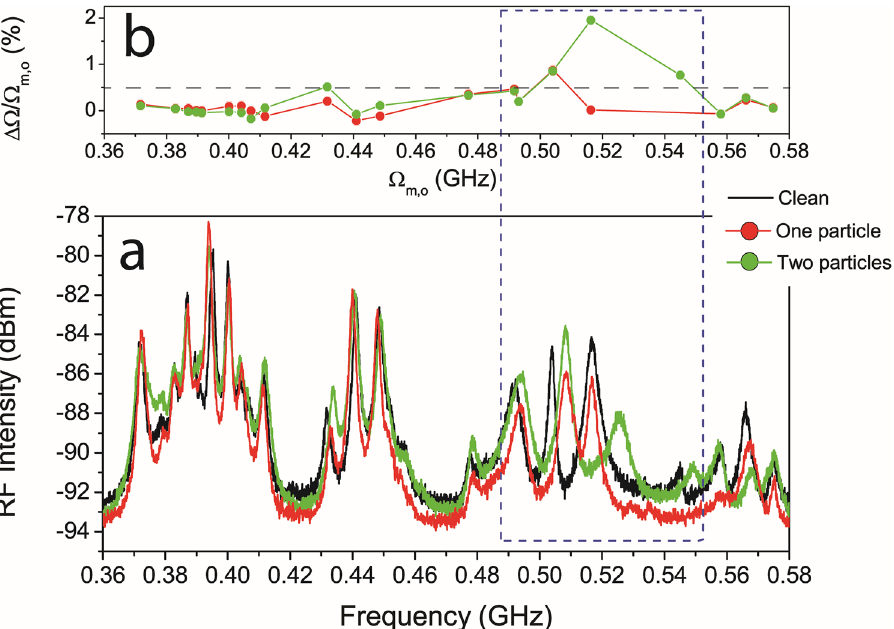
Figure 3. Experimental demonstration of the sensing principle ( a ) Transduced mechanical modes in the frequency range of the pinch modes family for the case of the as-fabricated OMC (black), the OMC with one particle (red) and with two particles (green). ( b ) Relative frequency shift of the mechanical modes with respect to the eigenfrequencies displayed by the as-fabricated OMC. The horizontal black dashed line corresponds to the typical mechanical linewidth of the observed modes. The blue dashed box highlights the region in which the mechanical modes are significantly affected by the presence of